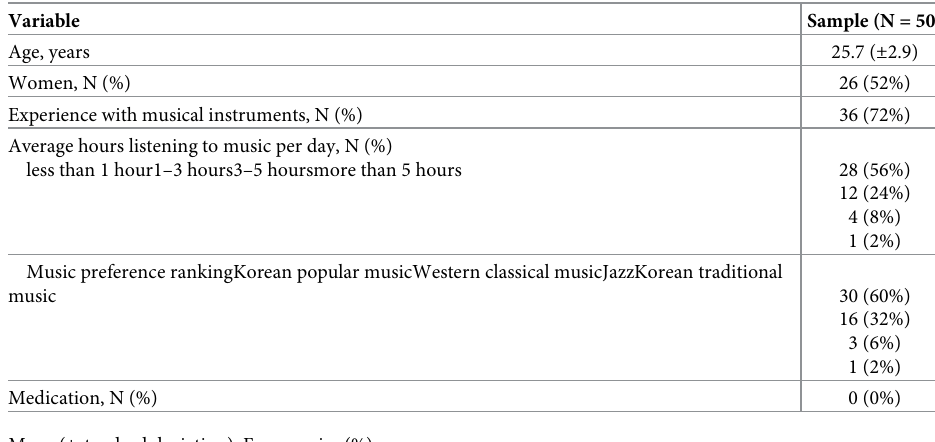
As shown in Table 2, significant treatment effects were observed for all three pain response variables. Pairwise multiple comparisons tests were conducted to assess which treatment con- ditions differed from each other across the three pain variables. As shown in Table 3, pain responses during the music condition significantly differed from the news (PT, p < .001; PI, p = .002; PU, p < .001) and control conditions (PT, p < .001; PI, p = .009; PU, p = .022), with PT being higher, and PI and PU being lower. However, pain responses during the news condi- tion did not differ significantly from the control condition for any pain variable (PT, p = .282; PI, p = 1.000; PU, p = .318).